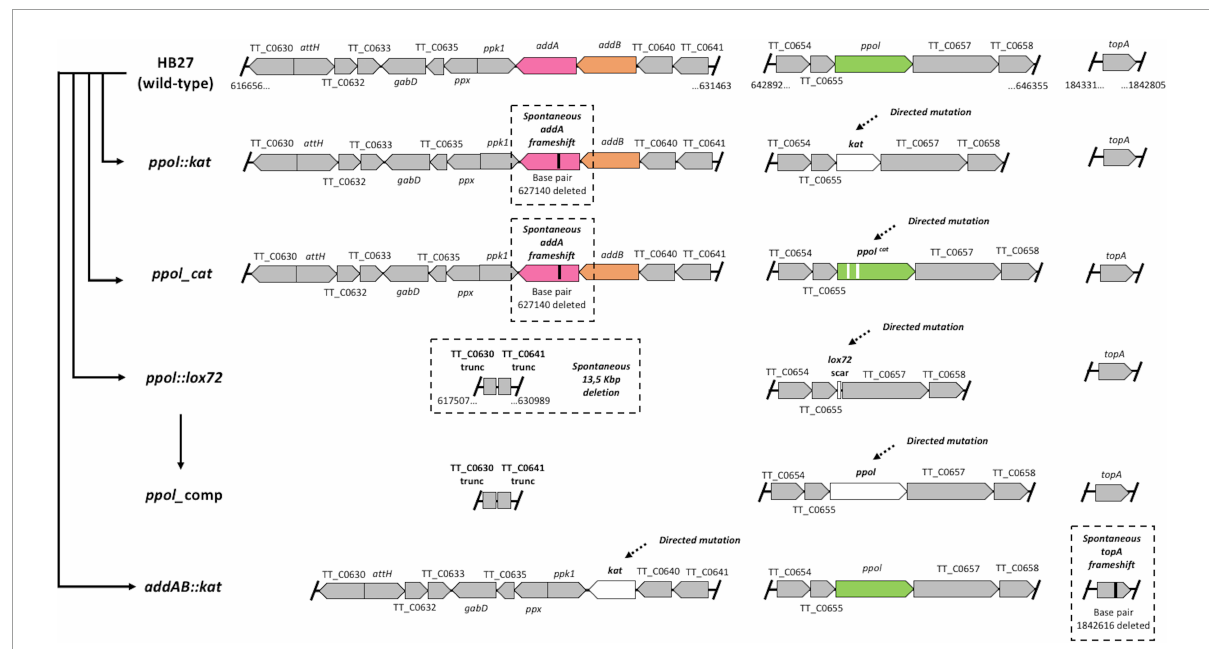
FIGURE1 Schematic overview of all strains tested in this work. Outline of the genomic context of ppol and addAB in Thermus thermophilus HB27. Individual genes are indicated as well as the genomic coordinates of the ends. Integrity of the topA gene is also shown. Mutations generated are designated in white with dashed arrows and major resultant compensatory mutations are in black with dashed squares. The order of construction among strains is indicated with solid arrows. Strains presented are HB27 (Wild type), ppol:kat [knockout of ppol by insertion of a kanamycin-resistant marker ( kat ) through homologous recombination], ppol_cat [removal of primase-polymerases (Ppol) catalytical activity by the generation of D70A and D72A residues substitution with CaldoCas9 system], ppol:lox72 (markerless deletion of ppol through Cre–lox deletion system), ppol_comp (restoration of ppol in ppol:lox72 strain with CaldoCas9 system), addAB:kat ( addAB knockout by kat insertion through homologous recombination). The gene denominations as well as genomic coordinates for HB27 chromosome are